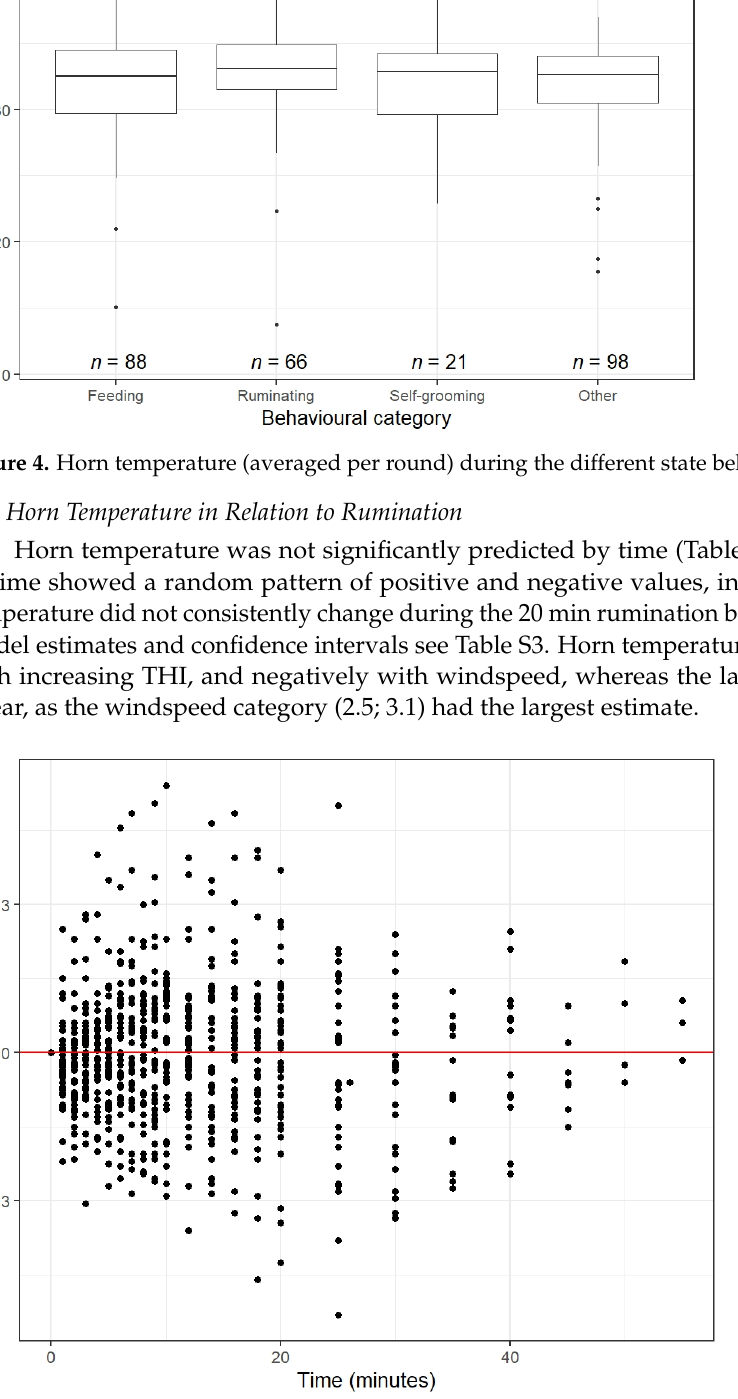
Figure 5. The relative horn temperature of ruminating cows ( n = 42) plotted against the ruminating duration. All temperature values are standardized for the starting temperature. For each cow, the starting temperature was set to zero and at every subsequent time moment the starting temperature was subtracted from the horn temperature at that specific time moment, resulting in either a positive or a negative value.